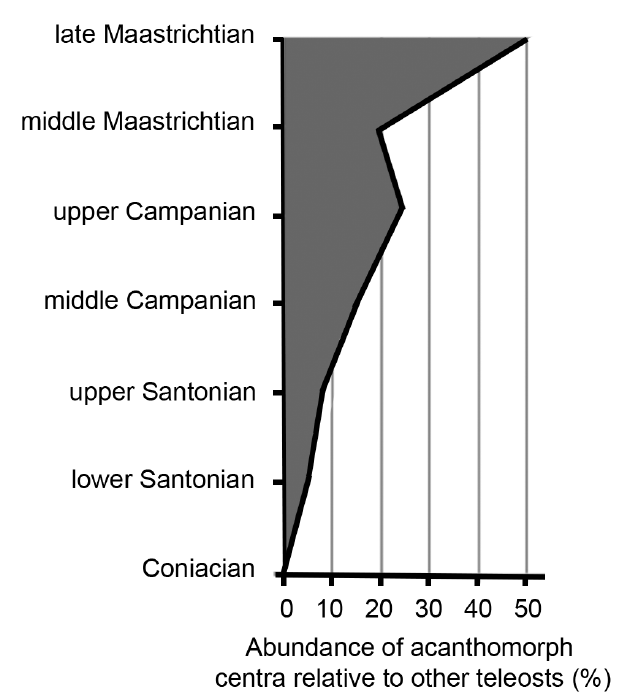
Figure 23. Graph showing the changing abundance of acanthomorph centra relative to the centra of other teleosts through the late Cretaceous. Lower Santonian based on local - ities in the lower John Henry Member of the Straight Cliffs Formation of Utah. Upper Santonian abundance based on counts of centra from localities in the Milk River Formation of Alberta. Middle Campanian abundance based on counts of centra from localities in the Wahweap Formation of Utah. Late Campanian abundance based on counts of centra from localities in the Kaiparowits Formation of Utah and the Belly River Group of Alberta. Middle Maastrichtian based on counts of centra from localities in the lower Hell Creek Formation of Montana. Upper Maastrichtian based on counts of centra from localities in the upper Hell Creek Formation of Montana. Data for the abundance of acanthomorphs from Utah from Brinkman et al. (2013; Table 10.2). Data for the abundance of acanthomorphs from the Milk River Formation in Table 1. Data for the abundance of acanthomorphs from the Belly River Group in Alberta and the upper and lower Hell Creek Formation from Brinkman et al. (2014: tables 3, 4). For the late Campanian, which is represented by localities in two widely separated geographic areas, the average of those two areas is used as a measure of the abundance of acantho - morphs at that